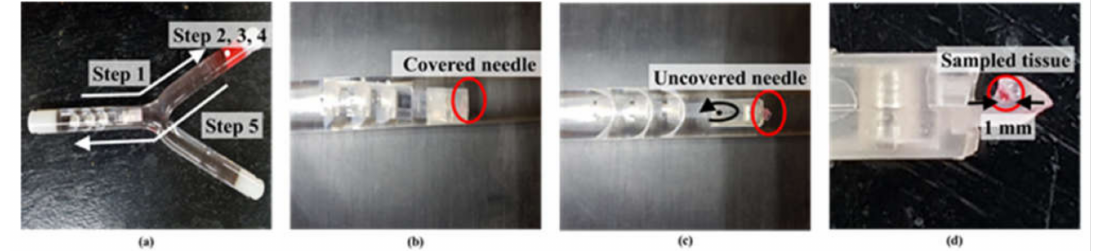
Figure 10. ( a ) Experiment testing the crawling and biopsy motions. ( b ) Covered needle. ( c ) Uncovered needle. ( d ) Collected sample